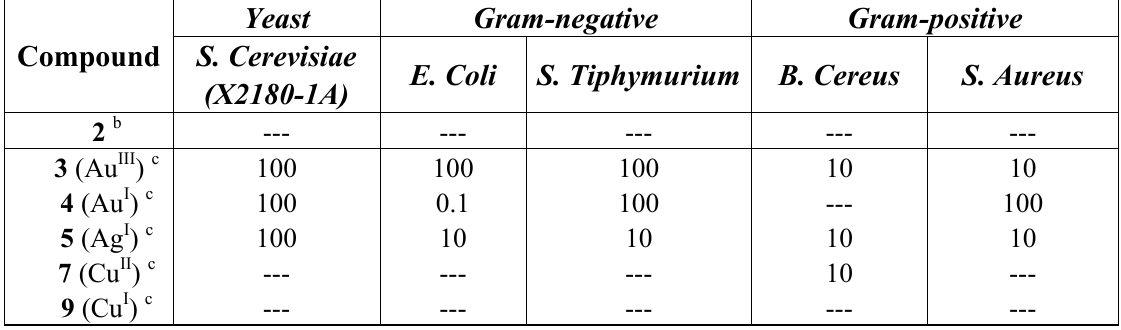
Table 3. Toxicity assesment of compounds 3 - 5 , 7 , 9 and ligand 2 against microbial organisms. a